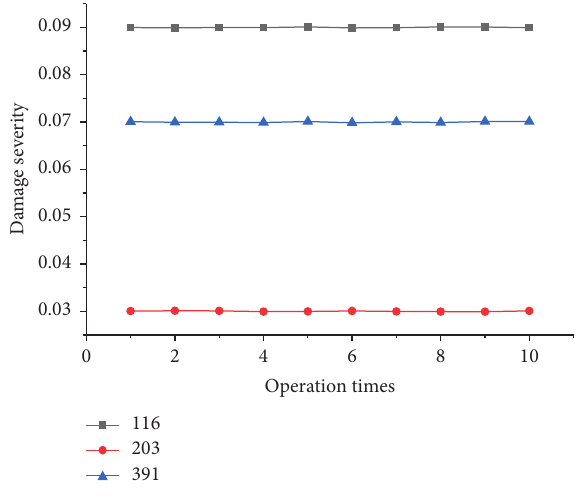
Figure 20: Damage severity identification of BA.